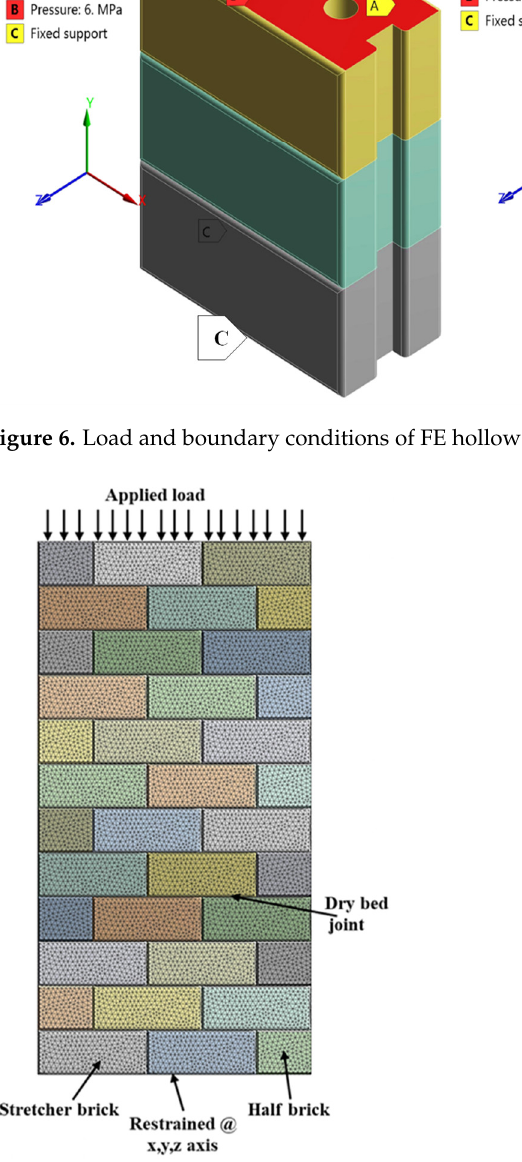
Figure 6. Load and boundary conditions of FE hollow and grouted prism.